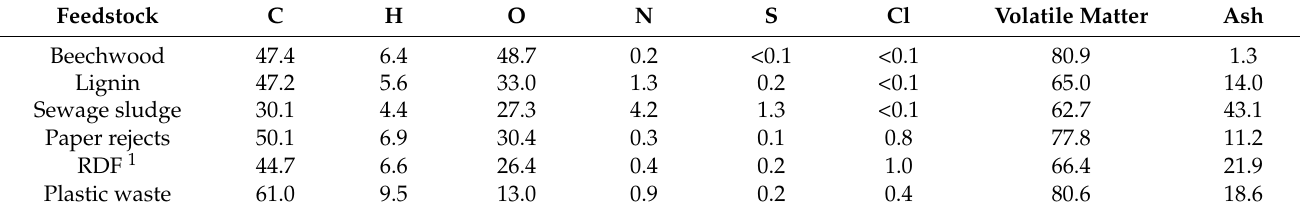
Table 1. Feedstock composition analyzed at the TNO facilities (wt% on dry